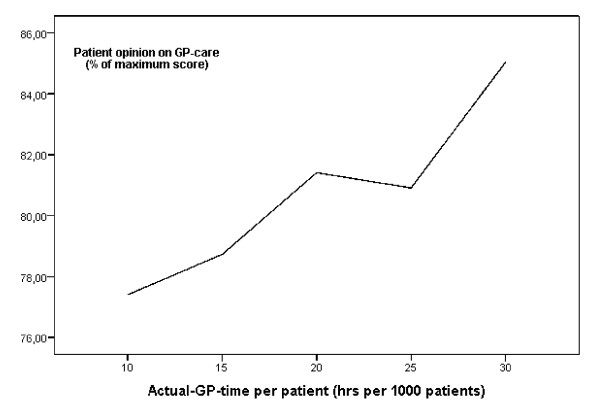
Actual GP time per 1000 patients and patient evaluations of GP performance. 10 hrs 77.4 (N = 11), > 15 hrs 78.7 (N = 82), > 20 hrs 81.4 (N = 92), >25 80.9 (N = 43), > 30 hrs 85.3 (N = 11).